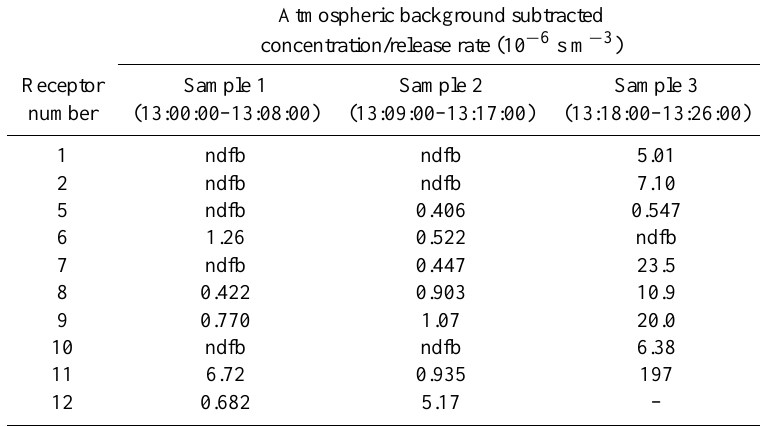
Table 2. Results (8min averages) from the second CityFlux Perfluorocarbon Tracer